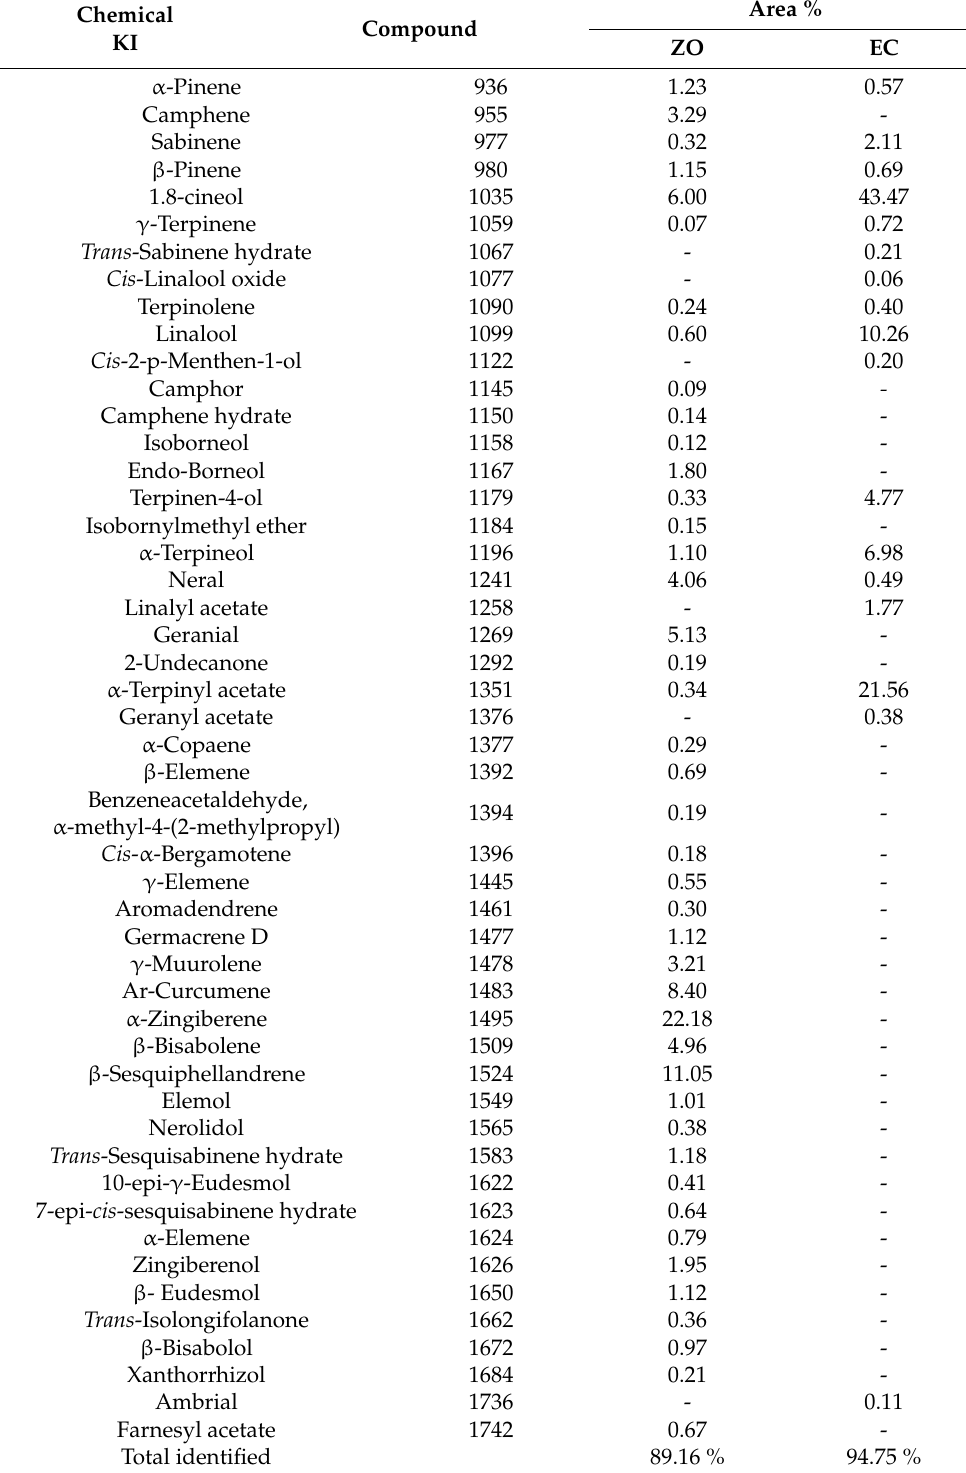
Table 1. Chemical Composition of Zingiber officinale Roscoe and Elettaria cardamomum (L.) Maton essential